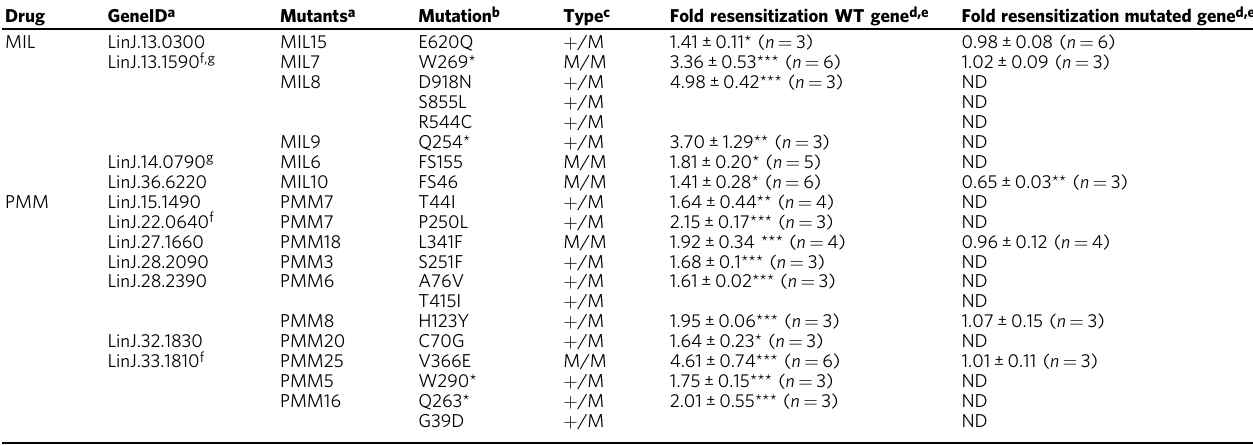
Table 1 Functional testing of selected genes in relevant miltefosine and paromomycin resistant mutants. Drug GeneID